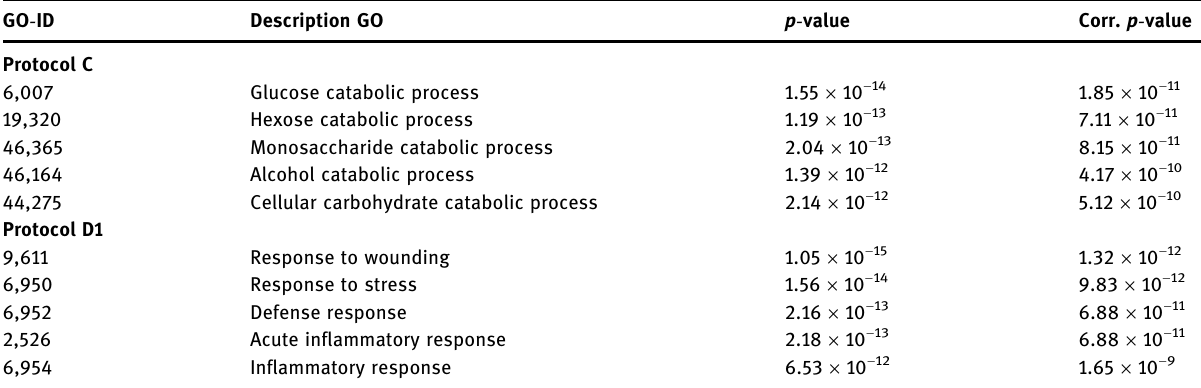
Table 4: GO categories of biological processes with the smallest p - values for proteins identi fi ed in the saliva sample prepared by FASP